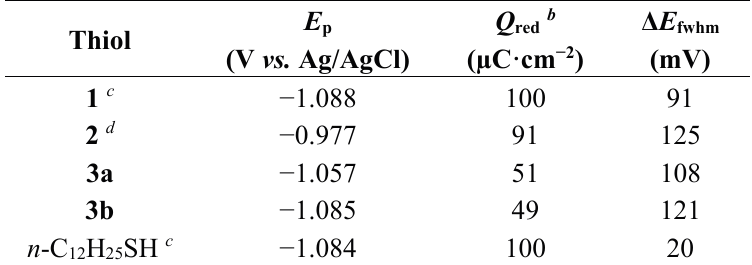
Table 1. Peak potential ( E p ), charge ( Q red ) and full width at half-maximum ( Δ E fwhm ) for the reductive desorption of thiol SAMs on Au(111), as measured by cyclic voltammetry a